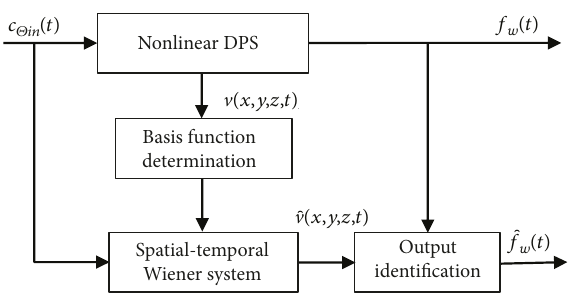
Figure 2: The schematic diagram for biorthogonal spatial-temporal Wiener